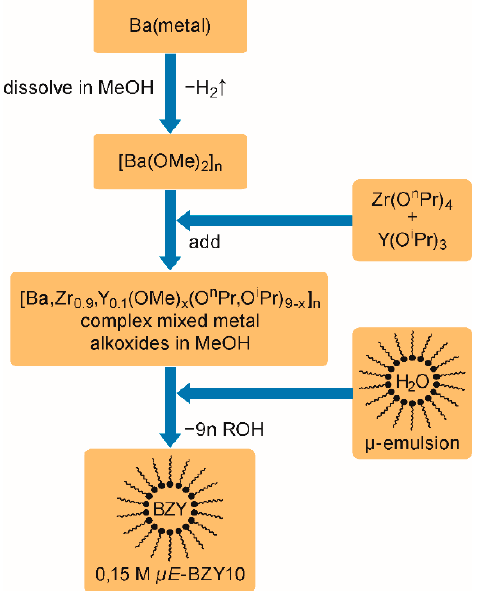
Figure 2. Synthesis procedure for BZY10 nanoparticle dispersions. (It should be noted that the indicated stoichiometry of the complex mixed metal alkoxide is idealized, and is the only basis for the calculation of the required amount of water in the form of the micro emulsion).